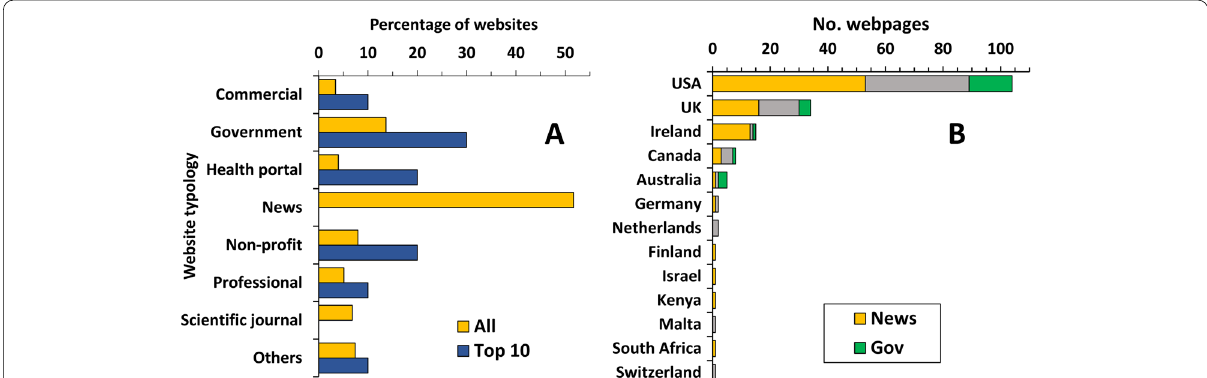
Fig. 1 Search trends in Google for “cannabis” and “medical cannabis.” Numbers represent search interest relative to the highest point on the chart for the given region and time for each search term. A value of 100 is the peak popularity for the term. A value of 50 means that the term is half as popular. A score of 0 means there was not enough data for this term. A Typologies of websites returned by Google. Data represent the percentage of websites across the whole search and the top 10 webpages in the Google search results. C, commercial; G, government; HP, health portals; N, news; NP, no profit; P, professional; SJ, scientific journal; O, other (unclassified). B Number of websites returned per country of origin. For each nation, news are in orange, government websites in green, and all other typologies in